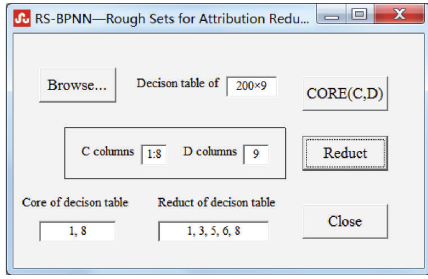
Figure 5: Attribution reduction.